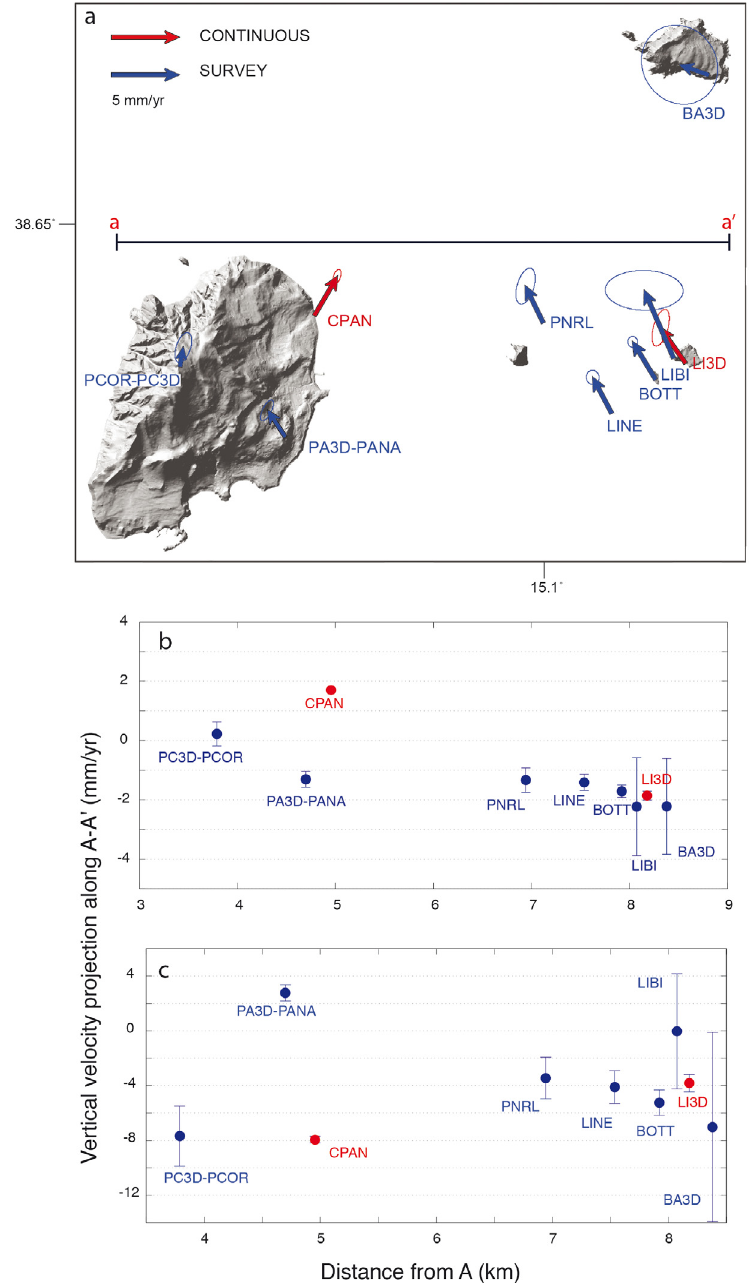
Figure 6. (a) the horizontal velocity field from the GPS survey style network of Panarea; (b) GPS and CGPS horizontal velocities projected along cross section a-a´; (c) CGPS and GPS vertical velocities projected along